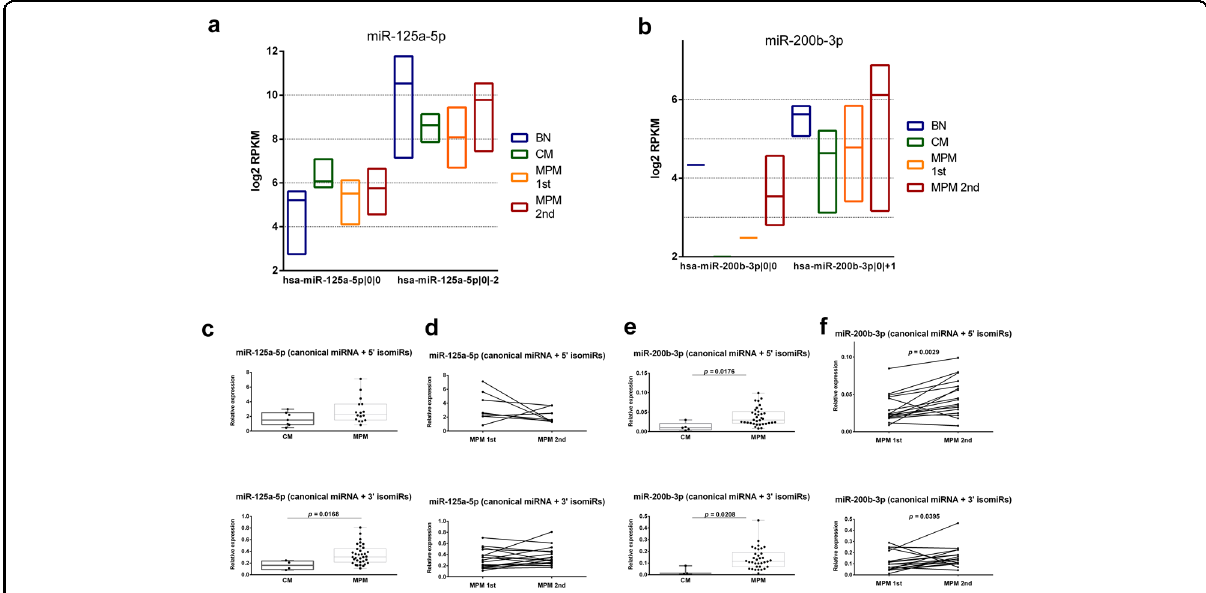
Fig. 5 Comparison of miR-125a-5p and miR-200b-3p isomiR expression in benign nevi (BN), cutaneous melanoma (CM), and multiple primary melanoma (MPM). a Floating bar chart of miR-125a-5p isomiR expression. Canonical miR-125a-5p (hsa-miR-125a-5p|0|0) shows a lower expression level and opposite expression trend in BN, CM, and MPM if compared to its shorter isomiR (hsa-miR-125a-5p|0| − 2). Bars represent min – max and median values. b Floating bar chart of miR-200b-3p isomiR expression showing the same expression trend for canonical miR-200b-3p (hsa-miR-200b-3p|0|0) and its longer isomiR (hsa-miR-200b-3p|0| + 1) in MPM groups. Canonical miR-200b-3p was not detected in CM samples. Bars represent min – max and median values. c Box and whiskers graph representation of canonical miR-125a-5p expression assessed with miRCURY LNA assay and overall expression of all miR-125a-5p isoforms, detected using miSCRIPT assay. Results show that the combined expression of miR-125a-5p isoforms of levels is higher in MPM compared to CM. The bar shows minimum and maximum values; superimposed points represent all individual values. d Before – after plot of canonical miR-125a-5p expression (miRCURY LNA assay) and all miR-125a-5p isoforms (miSCRIPT assay) show an opposite trend in the fi rst and second melanoma from the same patient. e Box and whiskers graph representation of canonical miR-200b-3p expression assessed with miRCURY LNA assay and overall expression of all miR-200b-3p isoforms, detected using miSCRIPT assay. Results show that in both there is a higher expression in MPM compared to CM. The bar shows minimum and maximum values; superimposed points represent all individual values. f Before – after plot of canonical miR-200b-3p expression (miRCURY LNA assay) and all miR-200b-3p isoforms (miSCRIPT assay) show both a higher expression in the second melanoma compared to the fi rst and from the same